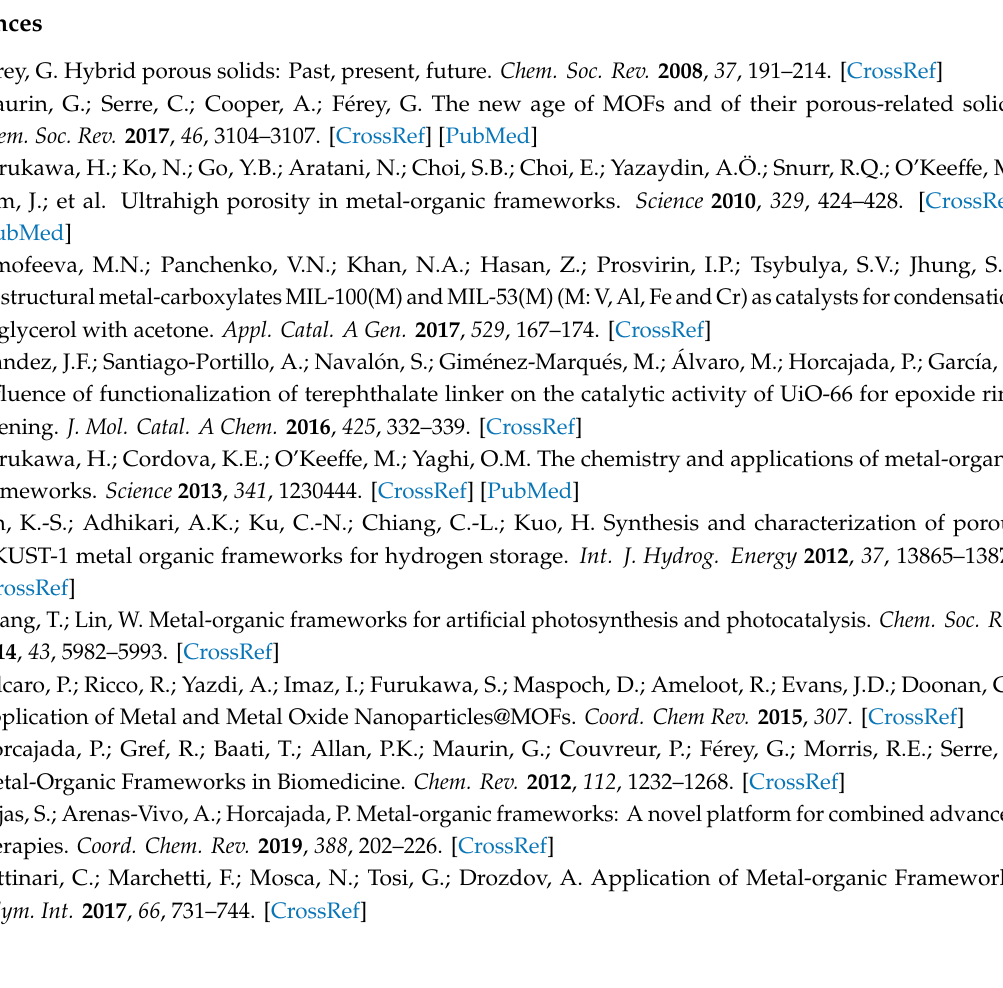
The resulting phases are indicated by the letter assigned in Table S1, Table S9. Particle size and reaction yield for the MW investigation of the system FeCl 3 · 6H 2 O / H 2 BDC-NH 2 in water (V H 2 O = 4 mL, T = 100 ◦ C, t = 5 min, Table S10. Particle size and reaction yield for the MW investigation of the system FeCl 3 · 6H 2 O / H 2 BDC-NH 2 in water (V H 2 O = 4 mL, T = 150 ◦ C, t = 5 min), Table S11. Particle size and reaction yield for the MW investigation of the system FeCl 3 · 6H 2 O / H 2 BDC-NH 2 / HCl in water ([Fe] = 0.05 M, V H 2 O = 4 mL, T = 100 ◦ C, t = 5 min), Table S12. Particle size and reaction yield for the MW investigation of the system FeCl 3 · 6H 2 O / H 2 BDC-NH 2 in ethanol (V EtOH = 4 mL, T = 150 ◦ C, t = 5 min), Table S13. Particle size and reaction yield for the MW investigation of the system FeCl 3 · 6H 2 O / H 2 BDC-NH 2 in ethanol (V EtOH = 4 mL, T = 150 ◦ C, t = 5 min, [Fe] = 0.2 M), Table S14. Particle size and reaction yield for the MW investigation of the system FeCl 3 · 6H 2 O / H 2 BDC-NH 2 in ethanol (V EtOH = 4 mL, T = 100 ◦ C, [Fe] = 0.1 M), Table S15. Particle size and reaction yield for the MW investigation of the system FeCl 3 · 6H 2 O / H 2 BDC-NH 2 in ethanol (V EtOH = 4 mL, T = 150 ◦ C, [Fe] = 0.1 M), Table S16. Particle size and reaction yield for the MW investigation of the system FeCl 3 · 6H 2 O / H 2 BDC-NH 2 in DMF (V DMF = 4 mL, T = 150 ◦ C, ligand:metal = 1:1), Table S17. Particle size and reaction yield for the MW investigation of the system FeCl 3 · 6H 2 O / H 2 BDC-NH 2 / HCl in DMF (V DMF = 4 mL, T = 150 ◦ C, t = 30 min, [Fe] =